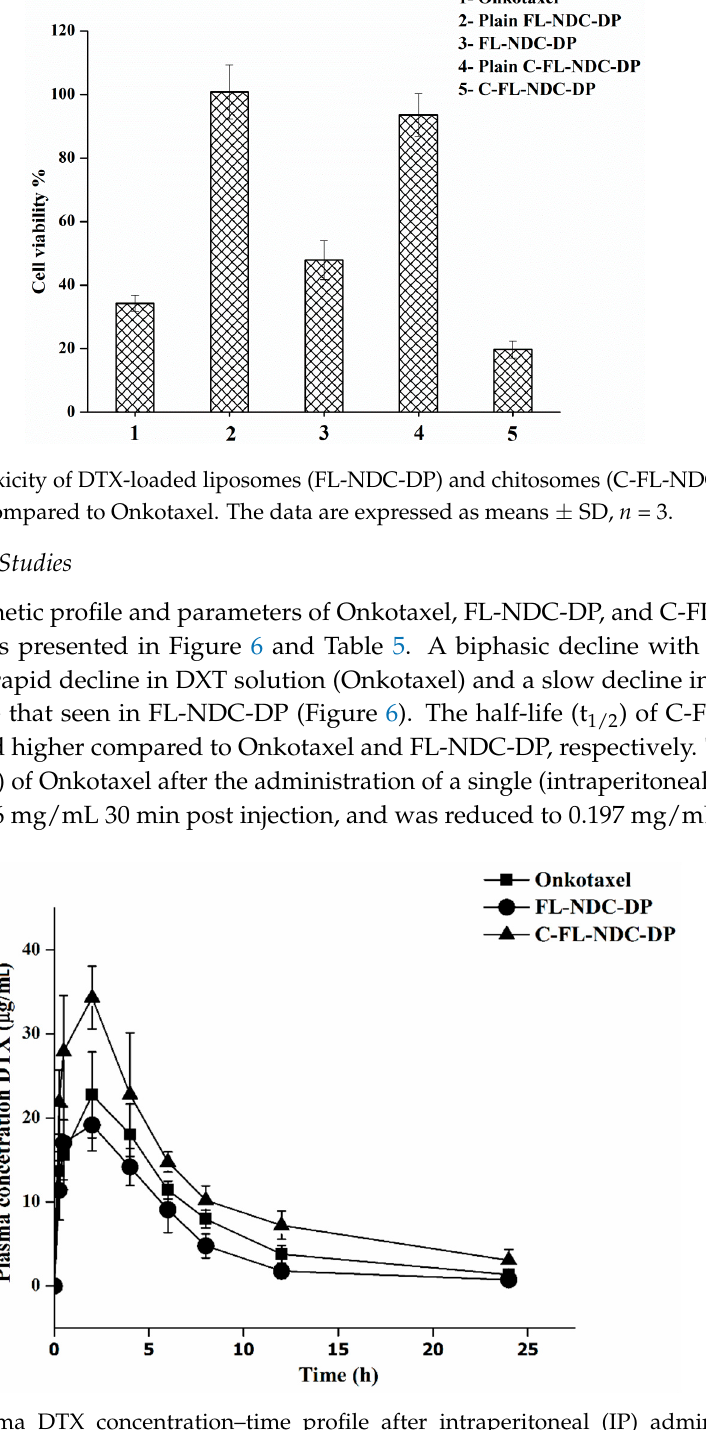
Figure 6. Plasma DTX concentration–time profile after intraperitoneal (IP) administration of FL-NDC- DP, C-FL-NDC-DP, and Onkotaxel to male Wistar rats at doses equivalent to 13 mg/kg ( n = 6). Table 5. Pharmacokinetic parameters following intraperitoneal (IP) administration of the DTX half-life; AUC—area under the curve; MRT—mean residence